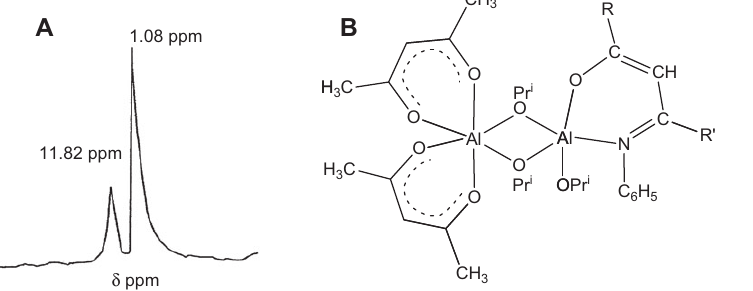
Figure 1 (A) 27 Al NMR spectrum of [3] at room temperature and (B) proposed structure of [(CH C(R ′ ) = NC